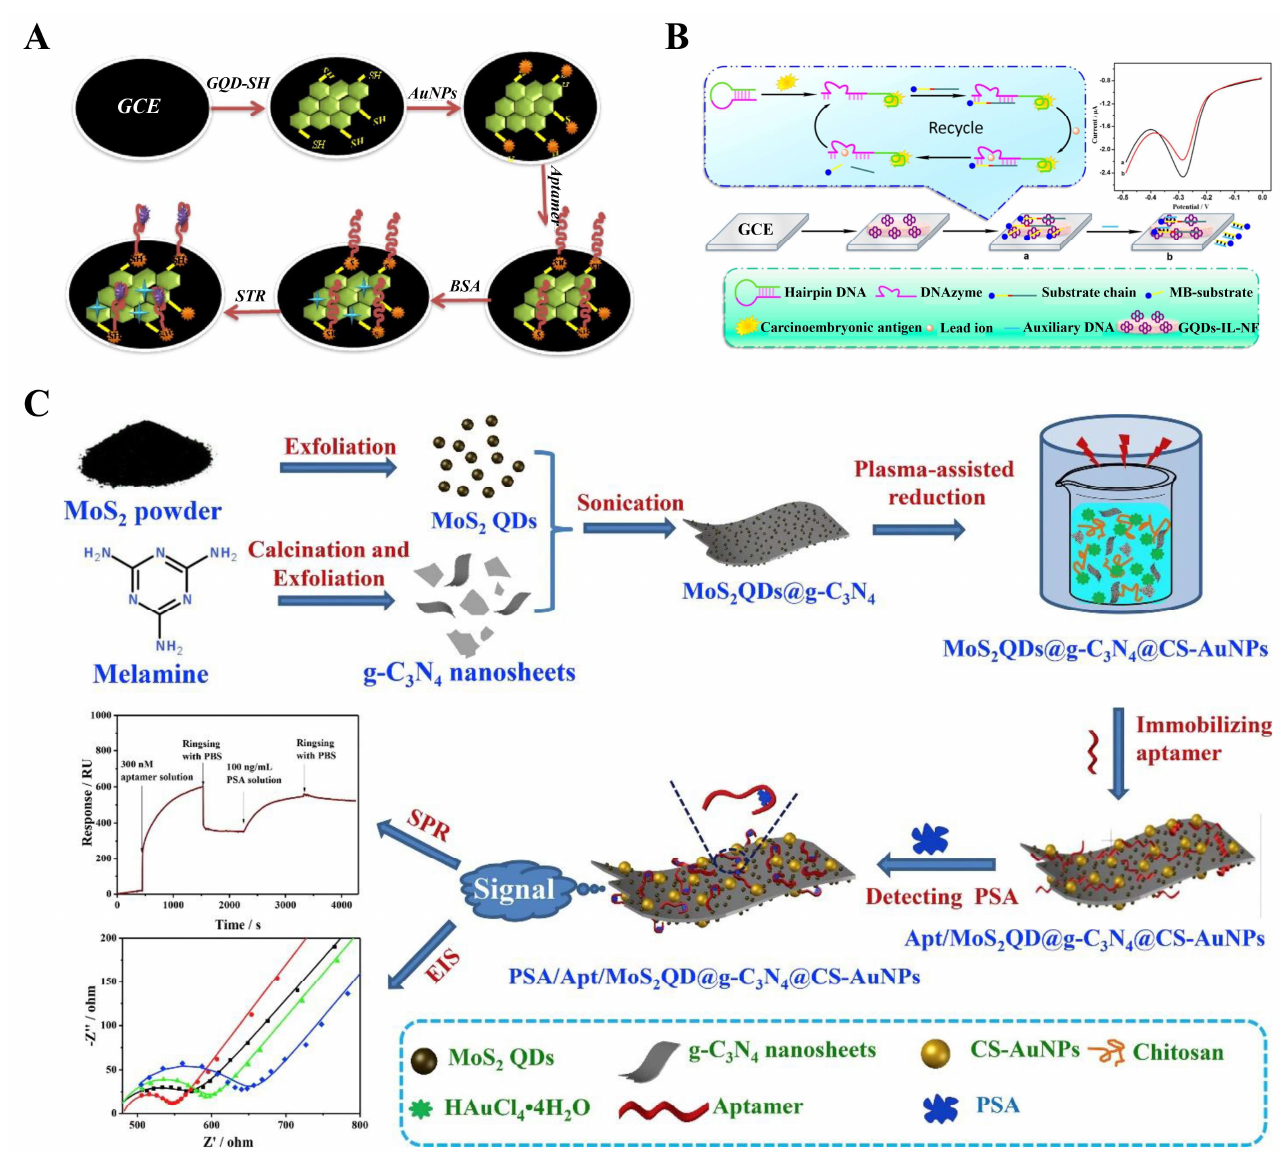
Figure 5. The 2D-QD-based electrochemical aptasensors. ( A ) Construction of electrochemical ap- tasensor based on AuNPs and GQD-SH for sensitive detection of STR. Adapted with permission from Ref. [91]. Copyright 2018 Elsevier. ( B ) Construction of the electrochemical aptasensor based on GQD-IL-NF nanocomposites for CEA detection combined with Pb 2+ -dependent DNAzyme-assisted signal amplification and the current response before and after the addition of CEA. Adapted with permission from Ref. [93]. Copyright 2018 Elsevier. ( C ) Fabrication of MoS 2 QD@g-C 3 N 4 @CS-AuNPs- based aptasensor for electrochemical detection of PSA and the signal collection using SPR and EIS. Adapted with permission from Ref. [94]. Copyright 2018 Elsevier.